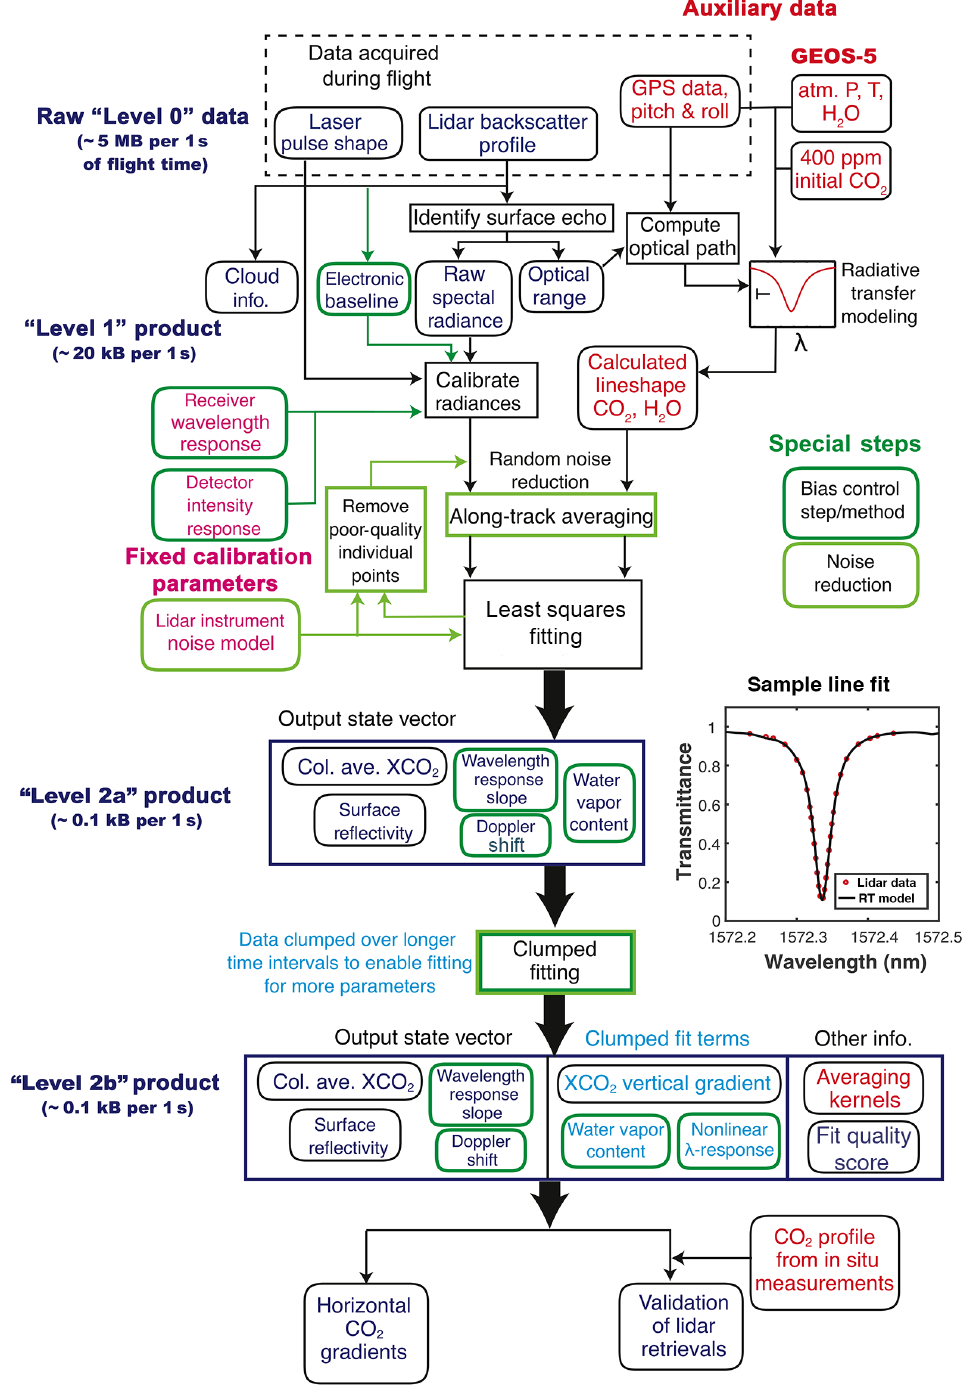
Figure 8. Processing diagram for retrieval algorithm used to estimate XCO 2 , range and other parameters from the lidar measurements as well as from other information from the aircraft. The results shown in this paper are labeled as Level 2a and Level 2b products in the